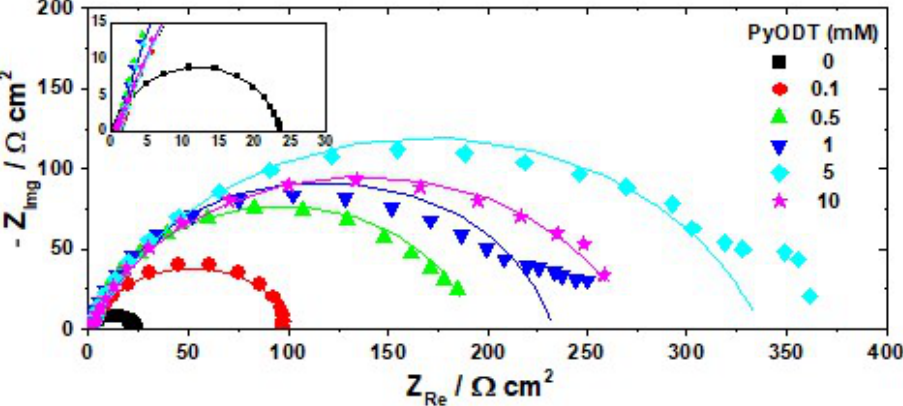
Figure 3. Nyquist diagrams recorded after 1 h immersion of C-steel surface in 1.0 M HCl solution in the absence and presence of different concentrations of PyODT. Insert: The impedance diagrams in an enlarged scale. Symbols–experimental impedance data; lines–calculated impedance.